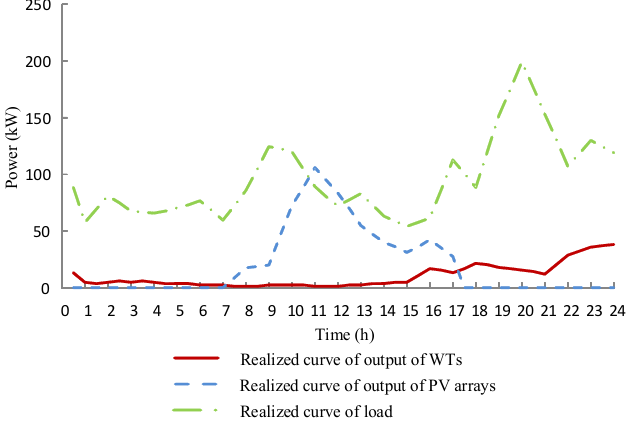
B Figure 8. Three-objective non-dominated solution set based on the proposed strategy. Furthermore, Figures 7 and 8 indicate that the non-dominated solution set of the proposed strategy is larger than that of the conventional strategy. According to this finding, after evaluating the flexibility constraints, the MREPS will sacrifice a portion of the economy, the utilization rate of renewable energy, and power fluctuations. We must then determine the optimal compromise solution from the Pareto non- dominated solution set to find the optimal day-ahead scheduling strategy for a typical day. The fuzzy comprehensive evaluation method can be used to obtain optimal compromise solutions from non-dominated Pareto solution sets, based on the conventional and proposed strategies, as discussed in Section 4. By the fuzzy comprehensive evaluation method, Point A and Point B are the solutions with the highest evaluation scores in the respective non-dominated solution sets of Figure 7 and Figure 8, respectively. Therefore, Points A and B represent optimal compromise solutions in Figure 7 and Figure 8, respectively. Finally, based on the relevant decision variables, the optimal day-ahead scheduling strategy for a typical day according to every optimal compromise solution can be determined. These are illustrated in Figures 9 and 10.